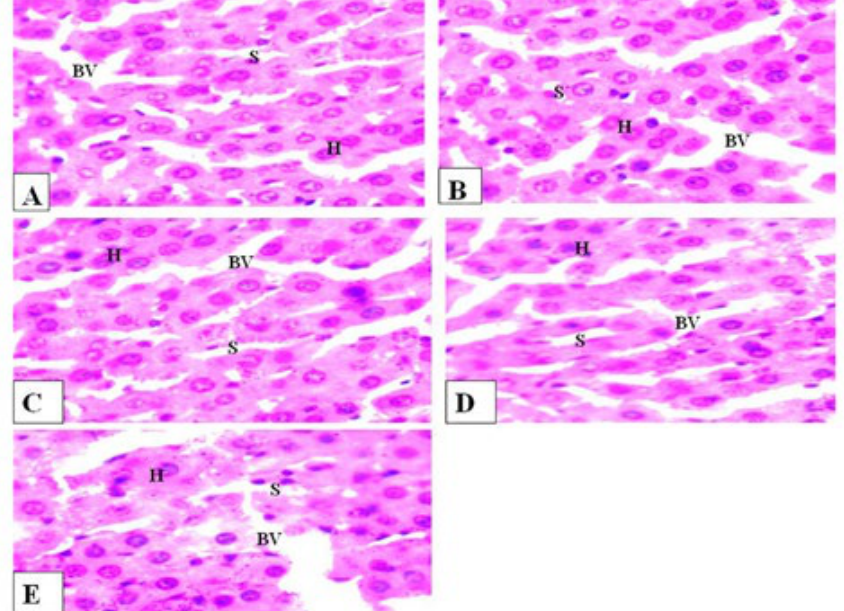
FIGURE 2 - Recovery liver sections photomicrographs showing; Plate A (Control), Plate B (62.5 mg/kg), Plate C (125 mg/kg), Plate D (250 mg/kg), Plate E (500 mg/kg). H: Hepatocytes disposed in sheet. S: sinusoids, BV: Blood